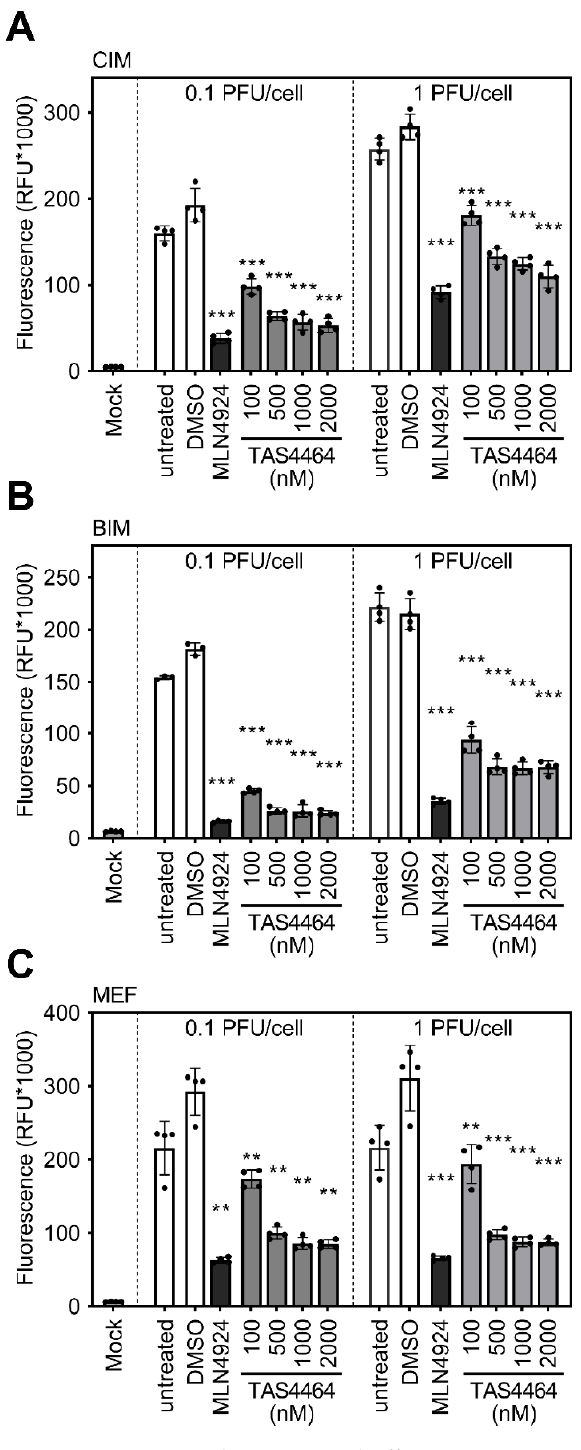
Figure 2. TAS4464 elicits antiviral effect against MCMV in different mouse cells. ( A ) CIM, ( B ) BIM, and ( C ) primary MEF cells were treated with indicated concentrations of TAS4464 (100–2000 nM; shown in grey) or MLN4924 (5000 nM; shown in black) and briefly afterwards infected with MCMV: eGFP . Solvent-treated (“DMSO”) and untreated cells served as controls (shown in white). After 3 days, fluorescence was quantified using a microplate multireader. The arithmetic mean ± SD is depicted. Asterisks indicate the level of statistical significance assessed by a two ‐ sided, heteroscedastic t test (** p < 0.01; *** p < 0.001).